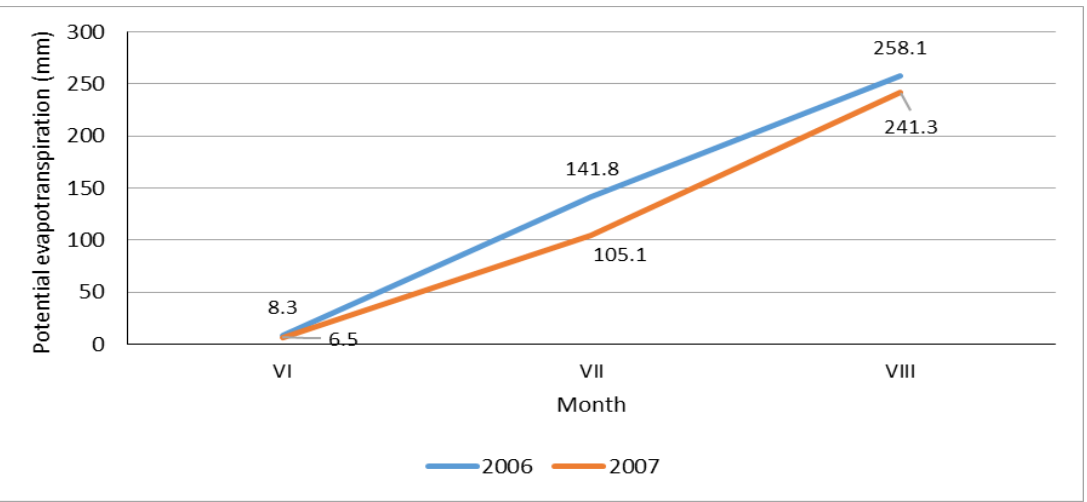
Figure 3. Cumulative potential evapotranspiration (mm) of the asparagus plants under drip irrigation conditions in particular months of the irrigation period.